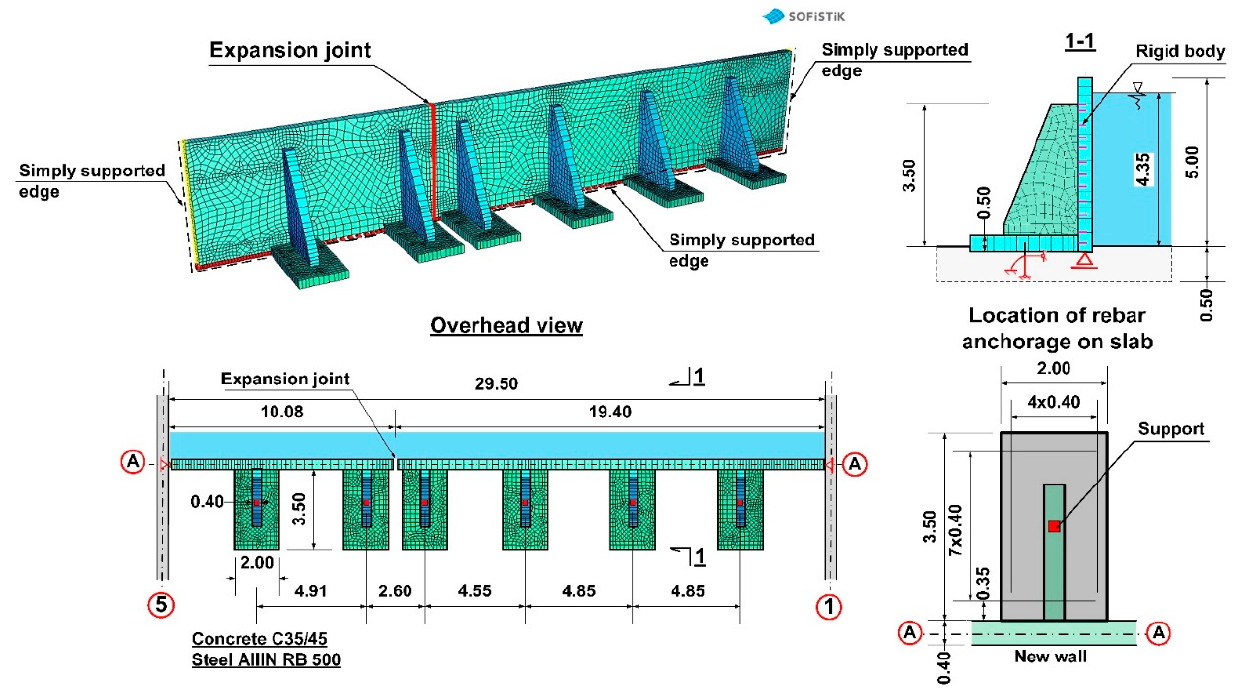
Figure 17. Numerical model for calculating wall support on axis A, which failed.